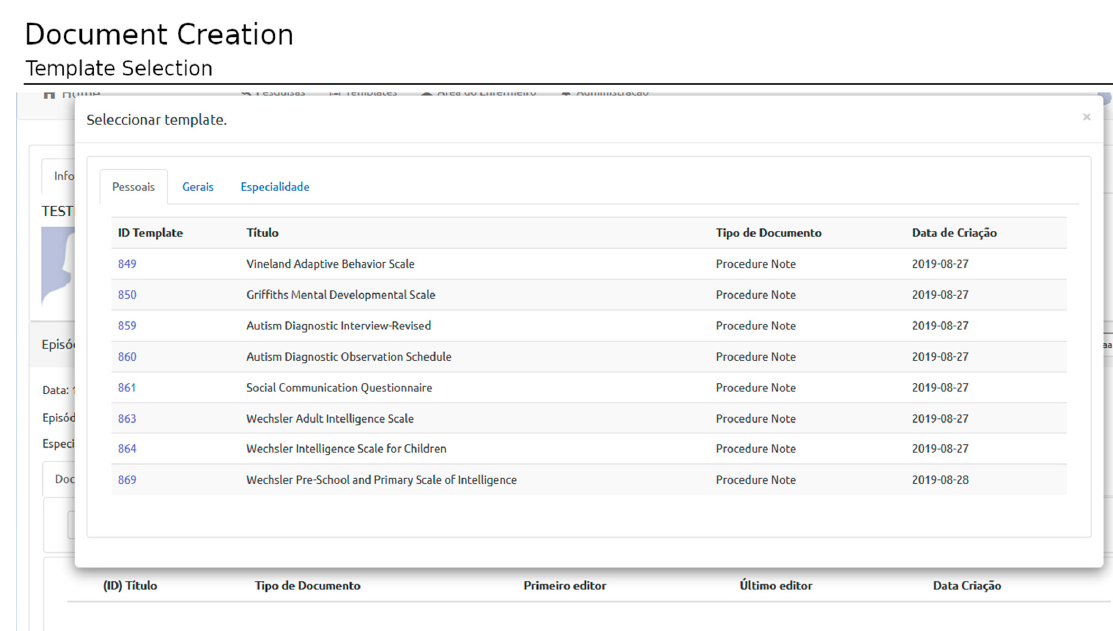
Figure 7. Document creation: Template selection. This window allows the user to select a template that is used to generate the clinical document structure, the clinical terminology, and the data types for each clinical term. This is relevant both for harmonized clinical practice and distributed research needs. (The Portuguese terms have the following translations in English: Selecionar Template: Select Template; Pessoais: Personal; Gerais: General; and Especialidade: Speciality). The user interface (UI) is designed according to the XML schemas imported from the selected template. The rules defined in the template are also implemented, i.e., data types, mandatory elements, etc. If the user does not comply with the rules, the document is not saved, and an error message is displayed in the UI (Figure 8).